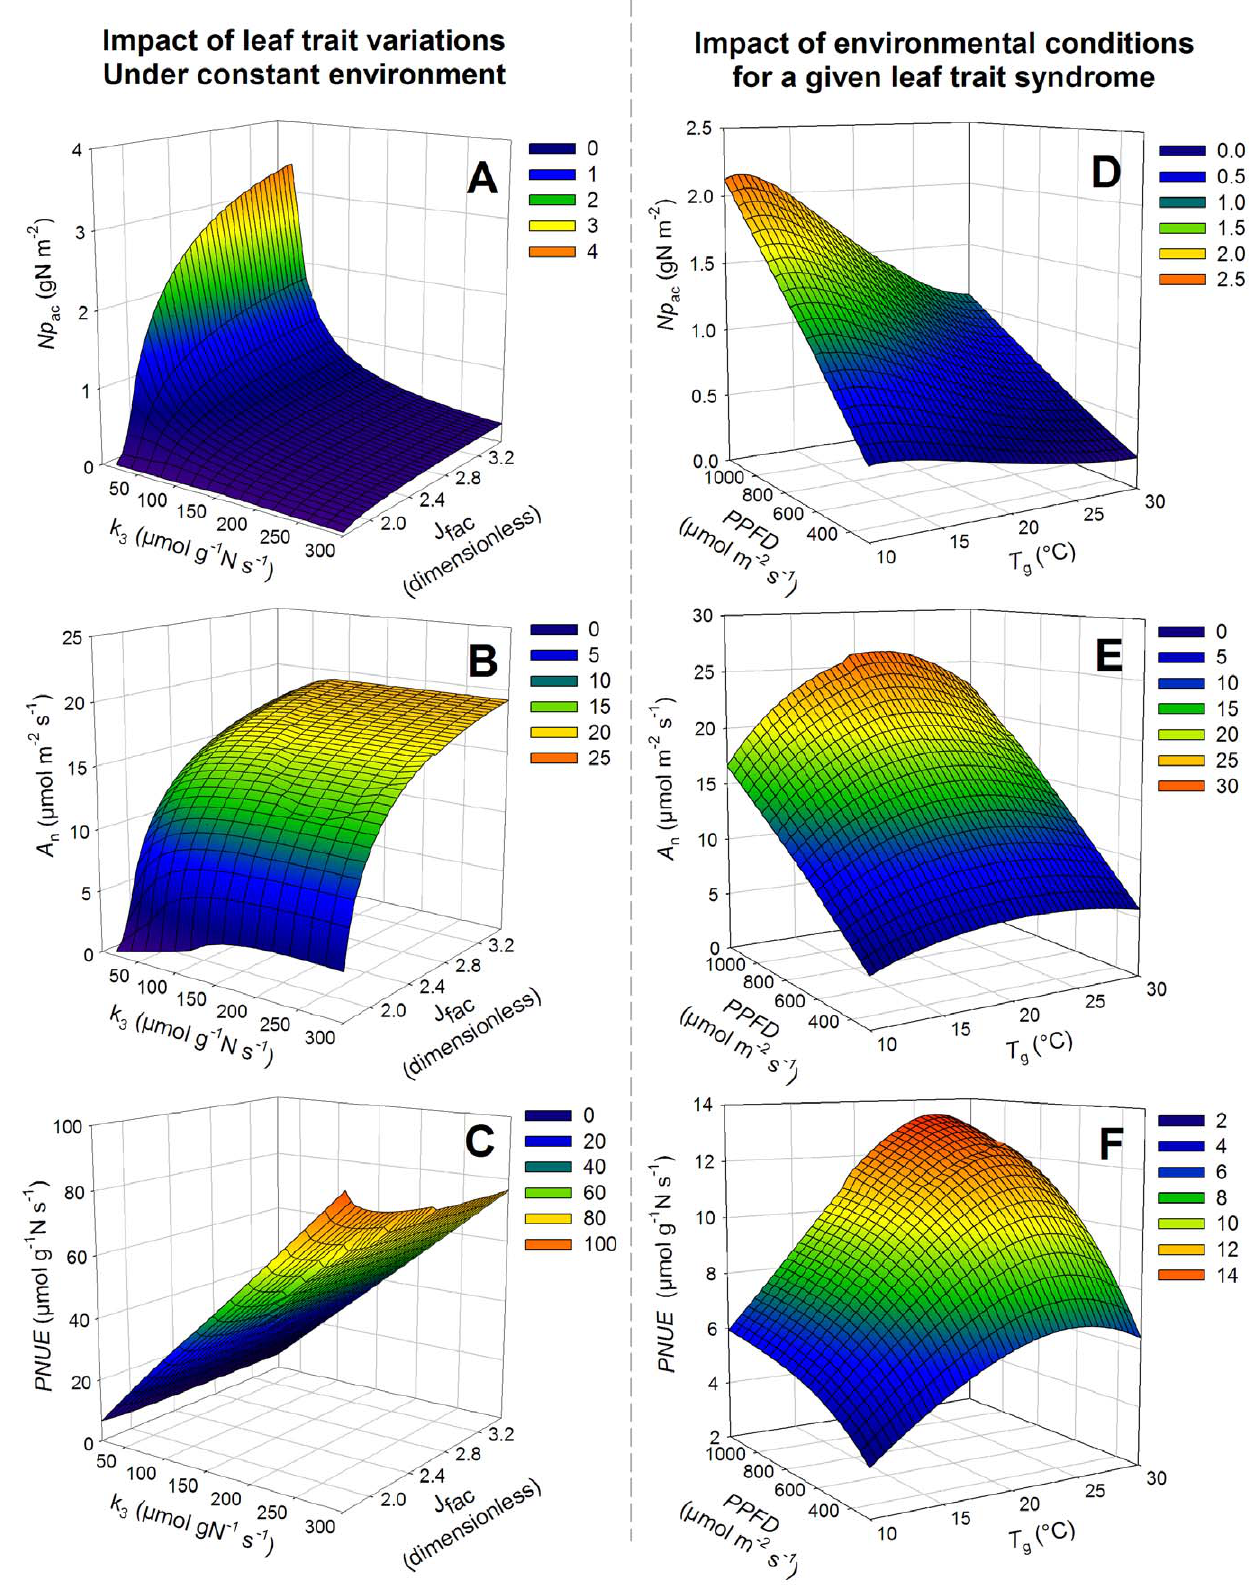
Figure 3. Relationships between simulated photosynthetic leaf N content ( Np ac ) (A), net photosynthesis ( A n ) (B) and photosynthetic N use efficiency ( PNUE ) (C) and the photosynthetic traits k 3 and J fac under standard mean environmental conditions ( PPFD